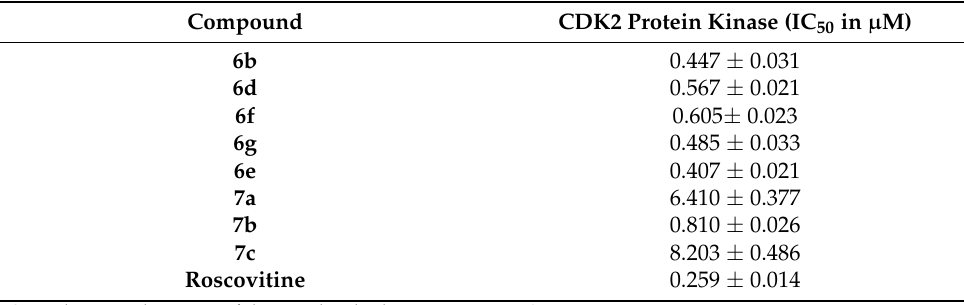
Table 3. CDK2 Protein Kinase Inhibitory Activity of compounds 6b,d–g and 7a–c